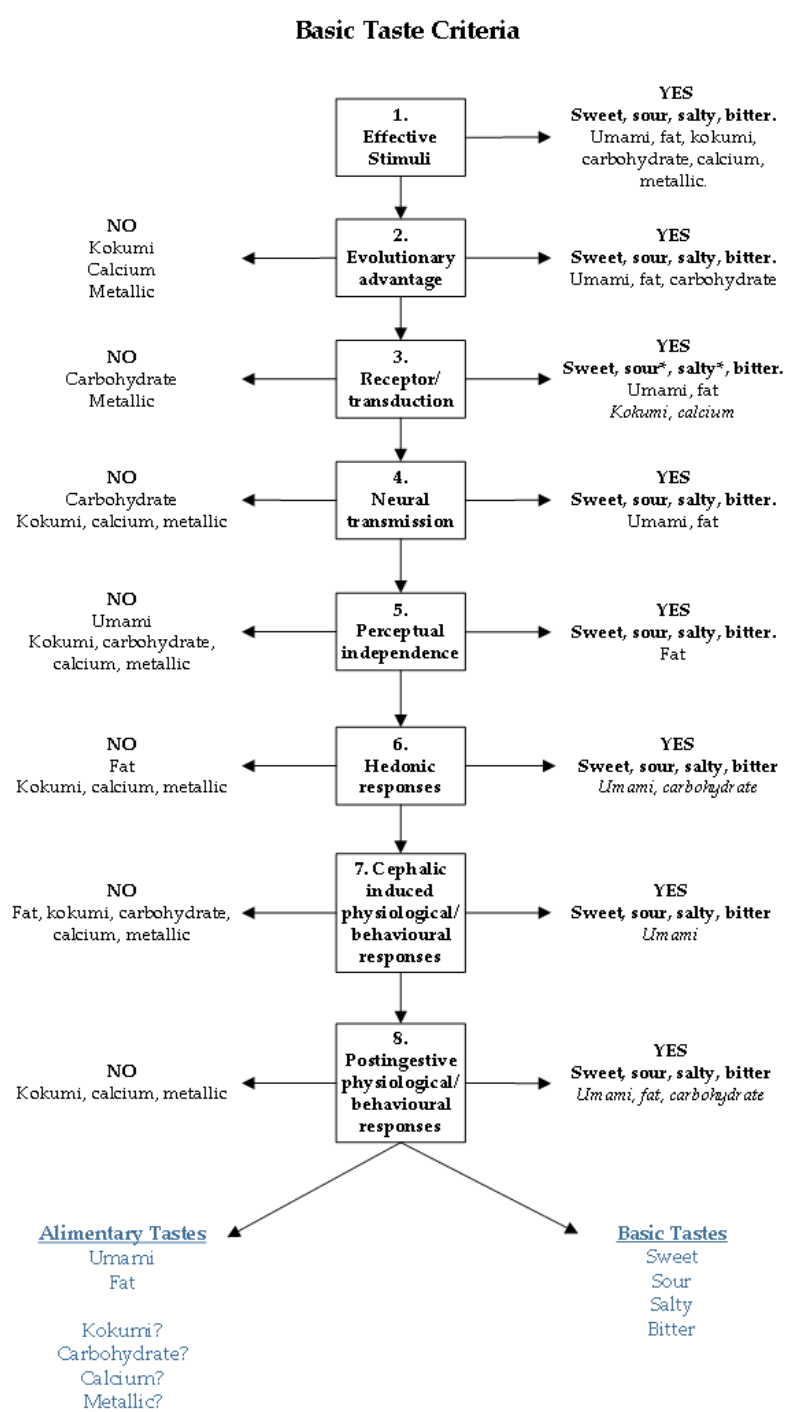
Figure 1. Criteria for tastes to fulfil to be classified as either basic tastes, or within a new taste subgroup. At the first criteria that a taste does not fulfil it is placed on the left-hand side of the model in the ‘NO’ section, those that fulfil the criteria remain on the right-hand side in the ‘YES’ criteria. * ENaC knockout mice have eliminated taste and neural responses to NaCl providing evidence for ENaC as the salt taste receptor [90], human studies have not yet confirmed the ENaC channel for salt taste detection. For the receptor criterion the ENaC receptor for salt taste, albeit in mice, has supporting evidence. * Type III sour sensing cells have been shown depolarise and reach action potential due to influx of H+ ions, providing evidence for sour taste detection, the specific proton channel responsible for this remains to be confirmed